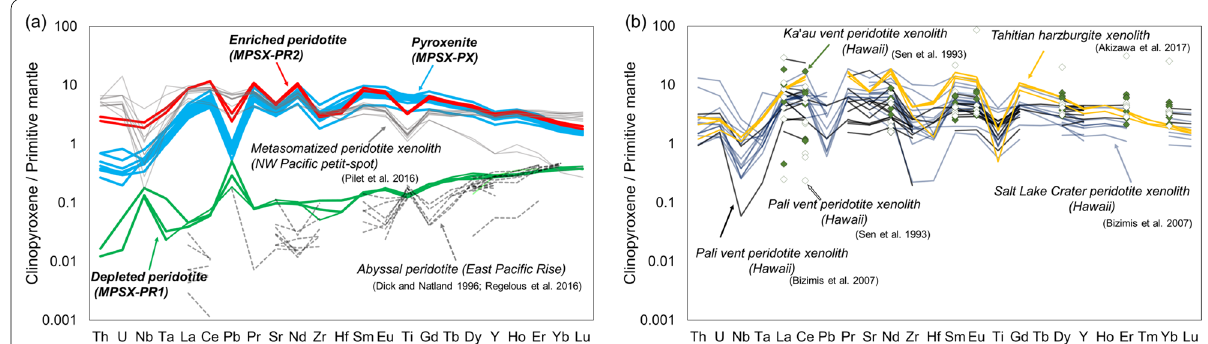
Fig. 7 Trace-element compositions of clinopyroxene. a A compilation of this study’s data. The depleted peridotite (MPSX-PR1) is shown as green lines. Red lines display the enriched peridotite (MPSX-PR2). Pyroxenite data (blue lines) include all pyroxenite xenoliths, xenocrysts (MPSX-PX1 to PX6), and isolated clinopyroxene xenocrysts. Gray solid lines show metasomatized peridotite xenoliths from the NW Pacific petit-spot reported by Pilet et al. (2016). Gray dotted lines represent the abyssal peridotite from East Pacific Rise (Dick and Natland 1996; Regelous et al. 2016). b Compilation of the other peridotite xenoliths from Pacific. The trace-element compositions of the Hawaiian peridotite xenoliths (Pali vent; black lines, and Salt Lake Crater; azure lines) are from Bizimis et al. (2007). REE concentrations of Hawaiian peridotite xenoliths (Ka’au vent; green diamonds, Pali vent; white diamonds) are also compiled here (Sen et al. 1993). Tahitian metasomatized harzburgite xenolith is from Akizawa et al. (2017). The data for the primitive mantle are from Sun and McDonough (1989). The detailed values are shown in Additional file 4: Table S5